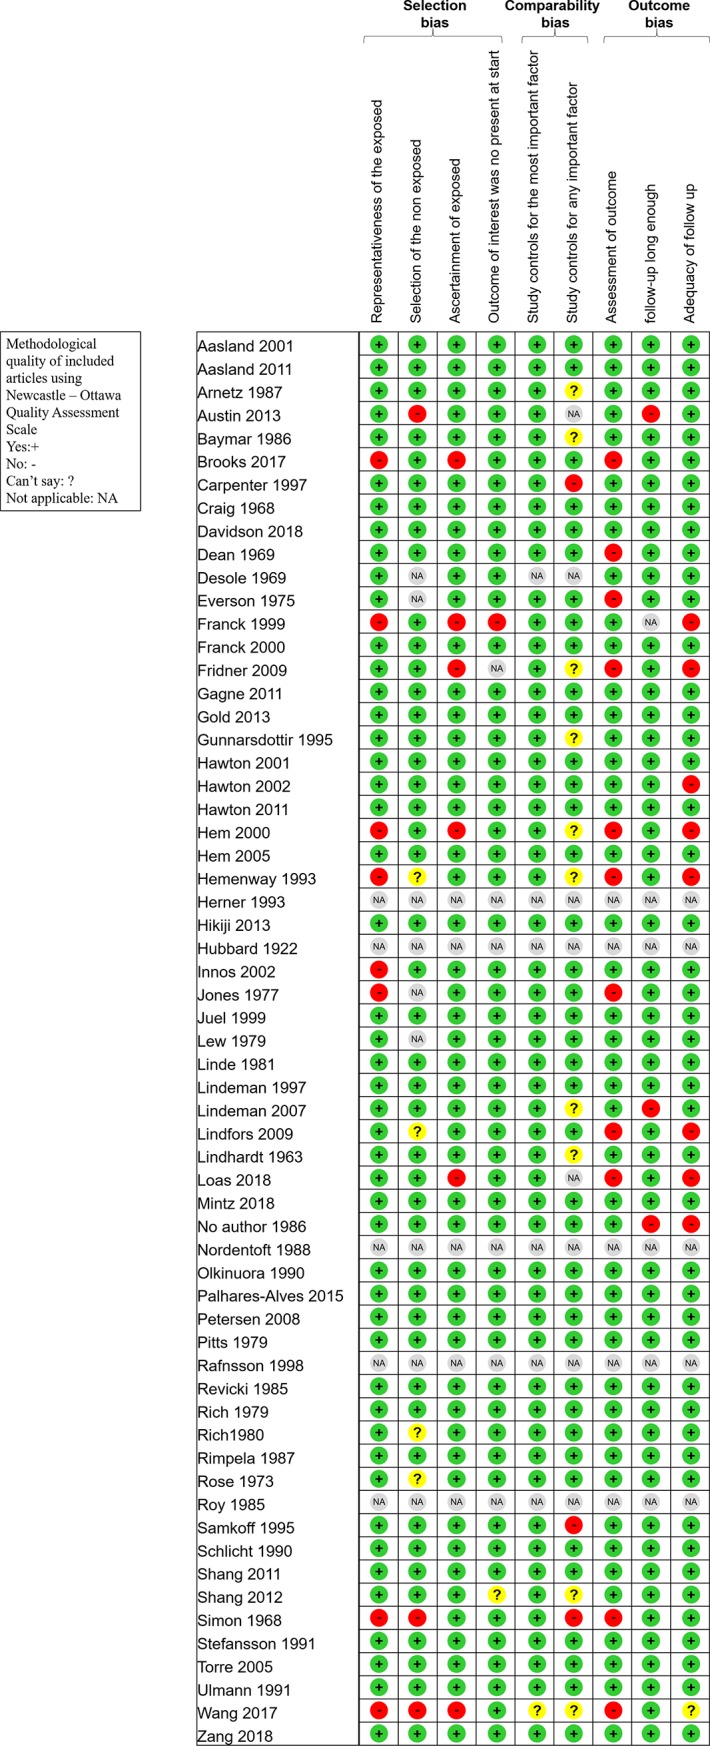
Methodological quality of included articles using Newcastle–Ottawa Quality Assessment Scale.